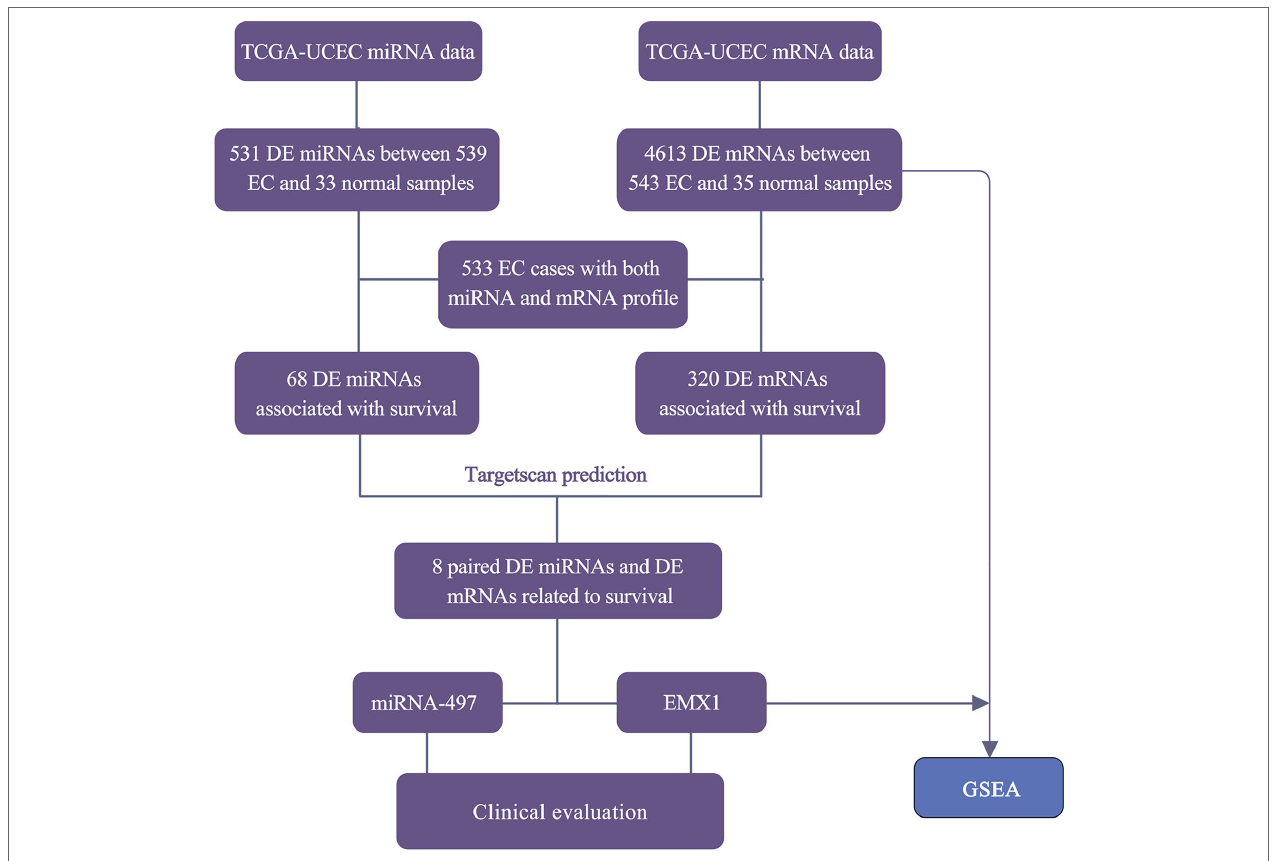
FIGURE 1 | Workflow for the screening and evaluation of DE mRNAs and DE miRNAs between EC and normal